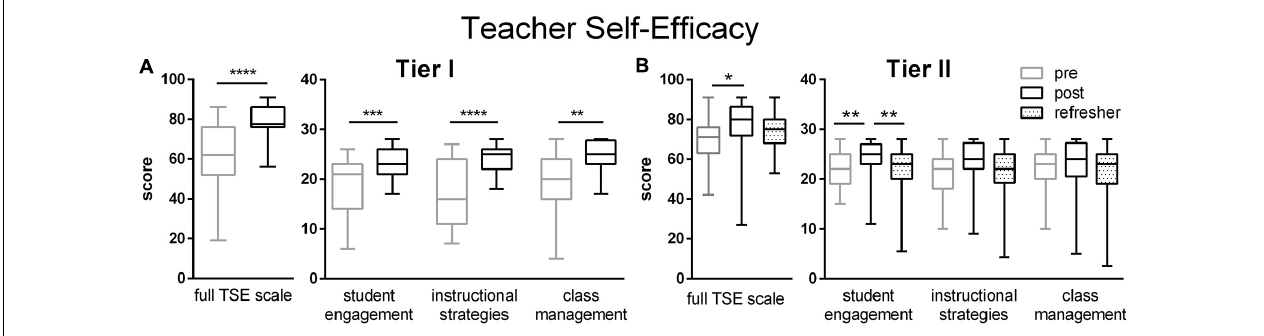
FIGURE 2 | Teacher Self-Efficacy ratings for Tier I (A) and Tier II (B) teachers on both full TSE scales and subscales for Student Engagement, Instructional Strategies, and Class Management. Gains in TSE were made during the workshop for both Tier I and Tier II teachers ( Tables 2 , 3 ). Pre (gray) represent retrospective pre ratings for the Tier I teachers and pre-workshop ratings for the Tier II teachers. Boxes represent 25th to 75th percentiles with an internal bar at the median. Whiskers delineate maximum and minimum data points. Tier I N = 23 pre, 24 post; Tier II N = 45 pre, 38 post, 56 refresher.*, **, ***, and **** represent p < 0.05, 0.01, 0.0001, and 0.00001, respectively.